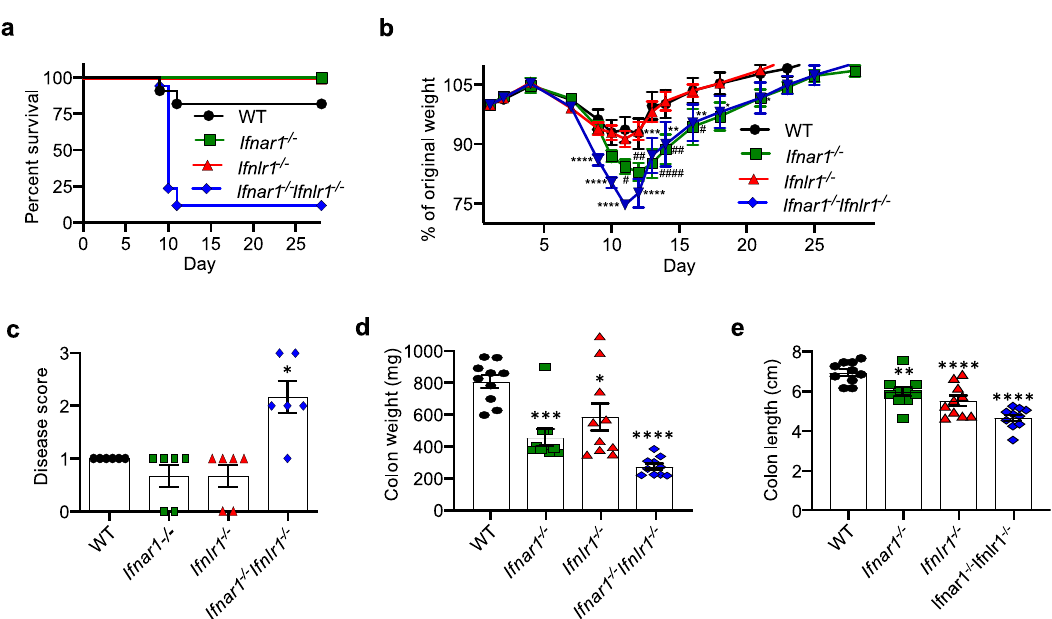
Fig. 1 Enhanced susceptibility of Ifnar1 − / − Ifnlr1 − / − mice to DSS treatment. a – e 6 – 8-week-old mice were exposed to 1.5% DSS in drinking water for 7 days, followed by regular drinking water for recovery. Mice were monitored daily for a survival and b weight loss WT, n = 11; Ifnar1 − / − , n = 6; Ifnlr1 − / − , n = 9; Ifnar1 − / − Ifnlr1 − / − , n = 17. In additional sets of experiments, mice were euthanized on day 11 and c disease score (WT, n = 7; Ifnar1 − / − , n = 6; Ifnlr1 − / − , n = 6; Ifnar1 − / − Ifnlr1 − / − , n = 6), d colon weight ( n = 10), and e colon length ( n = 10) were evaluated. Data are representative of two independent experiments ( a , b ) or pooled from two independent experiments ( c – e ). Symbols represent values of individual mice ( c – e ). Quantitative data were analyzed using b mixed model or d , e one-way analysis of variance (ANOVA) or c nonparametric Kruskal – Wallis test followed by Bonferroni ’ s ( b , d , e ) or Dunn ’ s multiple comparisons test ( c ) and represent mean values with SEM. b * P = 0.0217 (day 18), * P = 0.0478 (day 21), ** P = 0.0014 (day 14), ** P = 0.0096 (day 16), *** P = 0.0001 (day 13), **** P ≤ 0.0001 (days 9, 10, 11, 12), an asterisk (*) denotes Ifnar1 − / − Ifnlr1 − / − ; # P = 0.0131 (day 11), # P = 0.0445 (day 16), ## P = 0.0087 (day 12), ## P = 0.0043 (day 14), #### P ≤ 0.0001 (day 13), has symbol ( # ) denotes Ifnar1 − / − . c * P = 0.0376. d * P = 0.0211, *** P = 0.0002, **** P